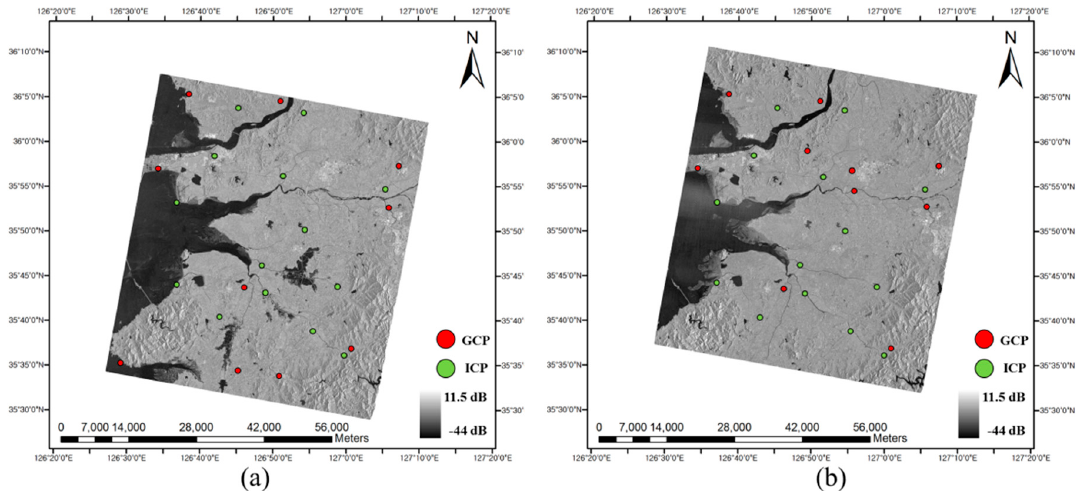
Figure 2. Radarsat-1 images and location of GCPs and ICPs: ( a ) RSAT 1 (3 August 2005); ( b ) RSAT 2 (27 August 2005).